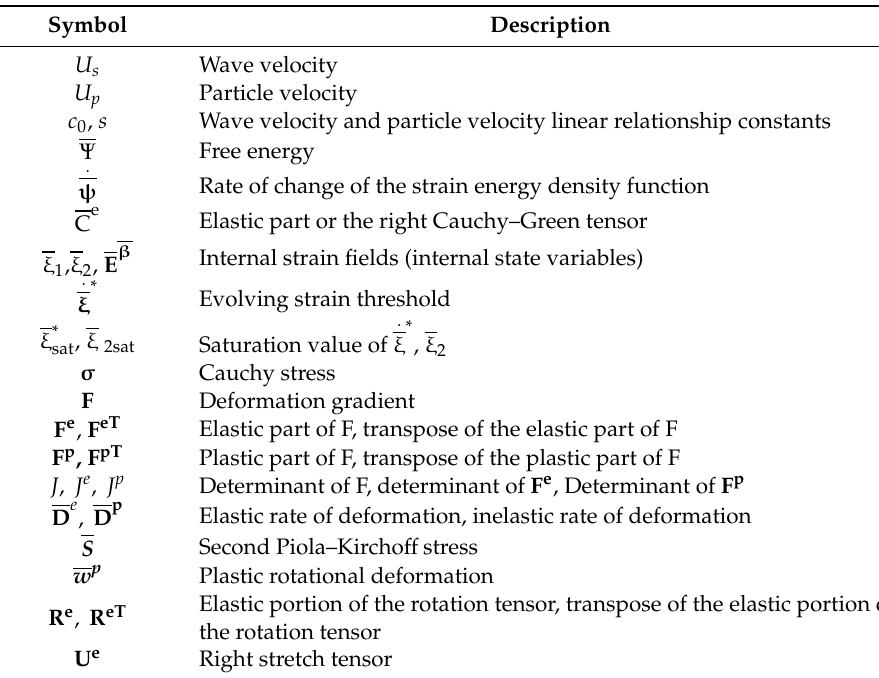
Table A1. Summary of symbol